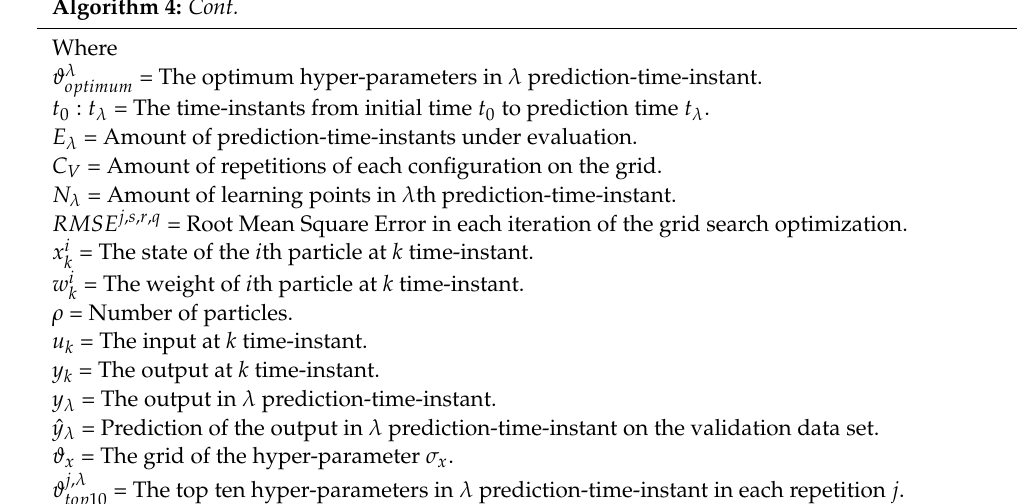
Algorithm 4: Cont.